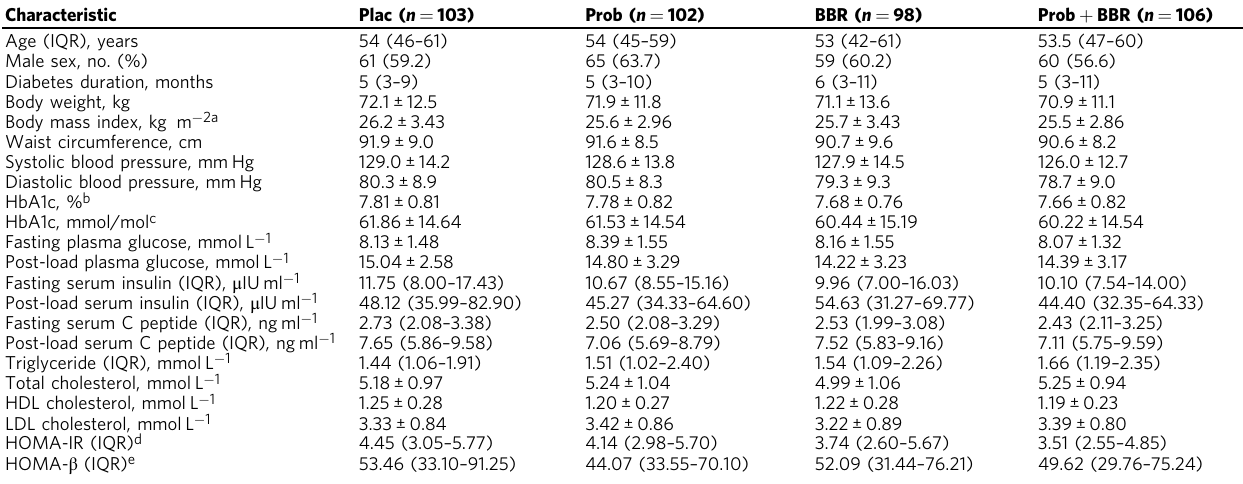
Table 1 Demographics and baseline characteristics of the randomized participants in Intervention